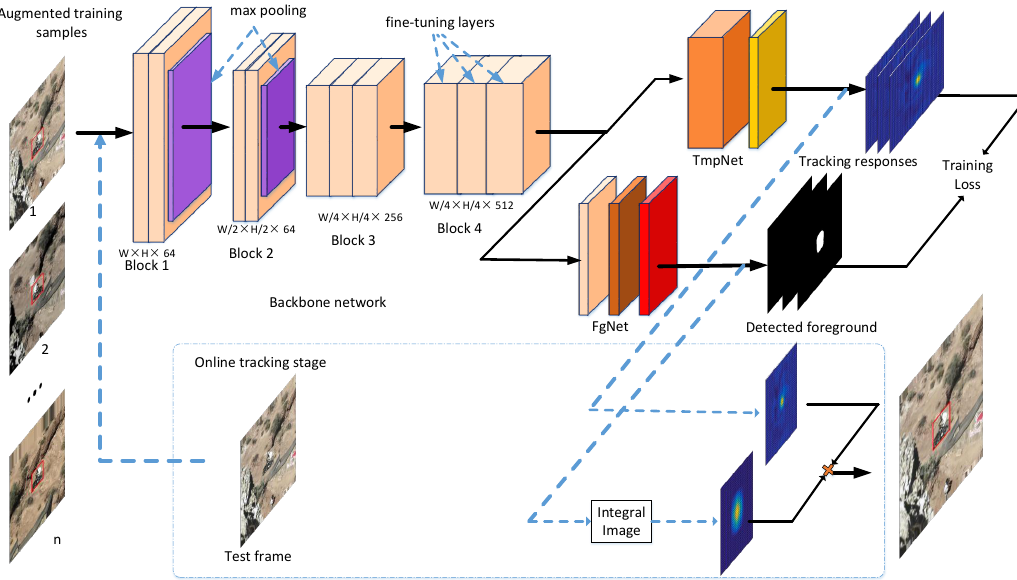
Figure 1. Overall architecture of our TFnet. In the proposed framework, the last block parameters of backbone network, channel-wise target template in the TmpNet and all the parameters in the FgNet are jointly trained with the augmented training samples. The black arrows indicate the training processes, while blue arrows are online tracking